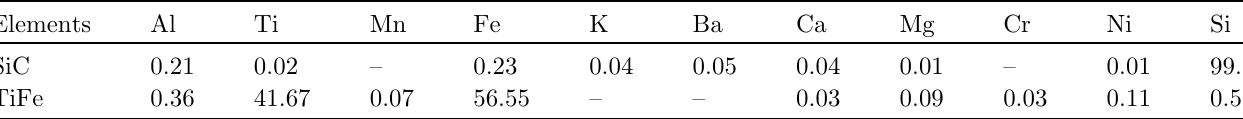
Table 1. Chemical composition of silicon carbide powder and ferrotitanium powders.